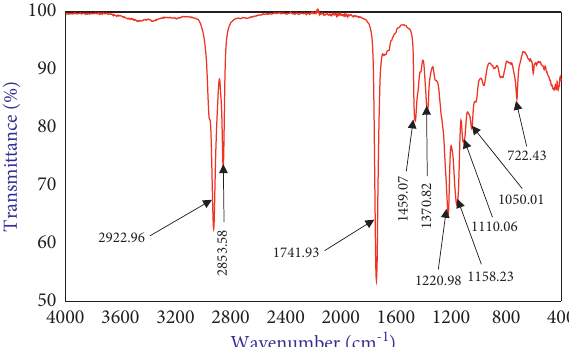
Figure 7: FTIR spectrum of fraction A from the methanol extract of V. camporum .